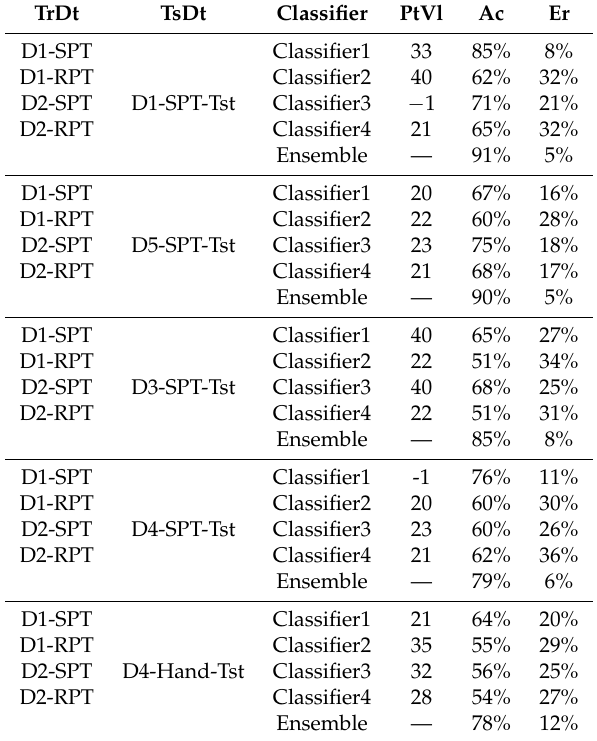
Table 5. Summary of classification accuracy (in %) obtained for different training and test devices with four condition-based classifiers and Ensemble of these classifier. D1 and D2 are considered as training devices and D3, D4 and D5 as test devices. Devices are kept at different positions (SPT, RPT, or Hand). The column headings are: Training Dataset (TrDt), Test Dataset (TsDt), maxIts-Parameter tuning Value for LR (PtVl), Accuracy (in %) (Ac) and Error (in %) (Ec). TrDt